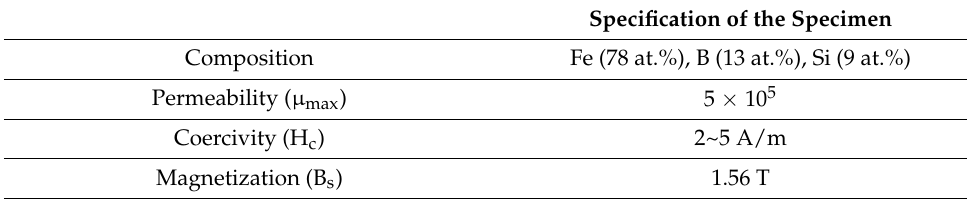
Table 2. Soft magnetic properties of the amorphous soft magnetic specimen